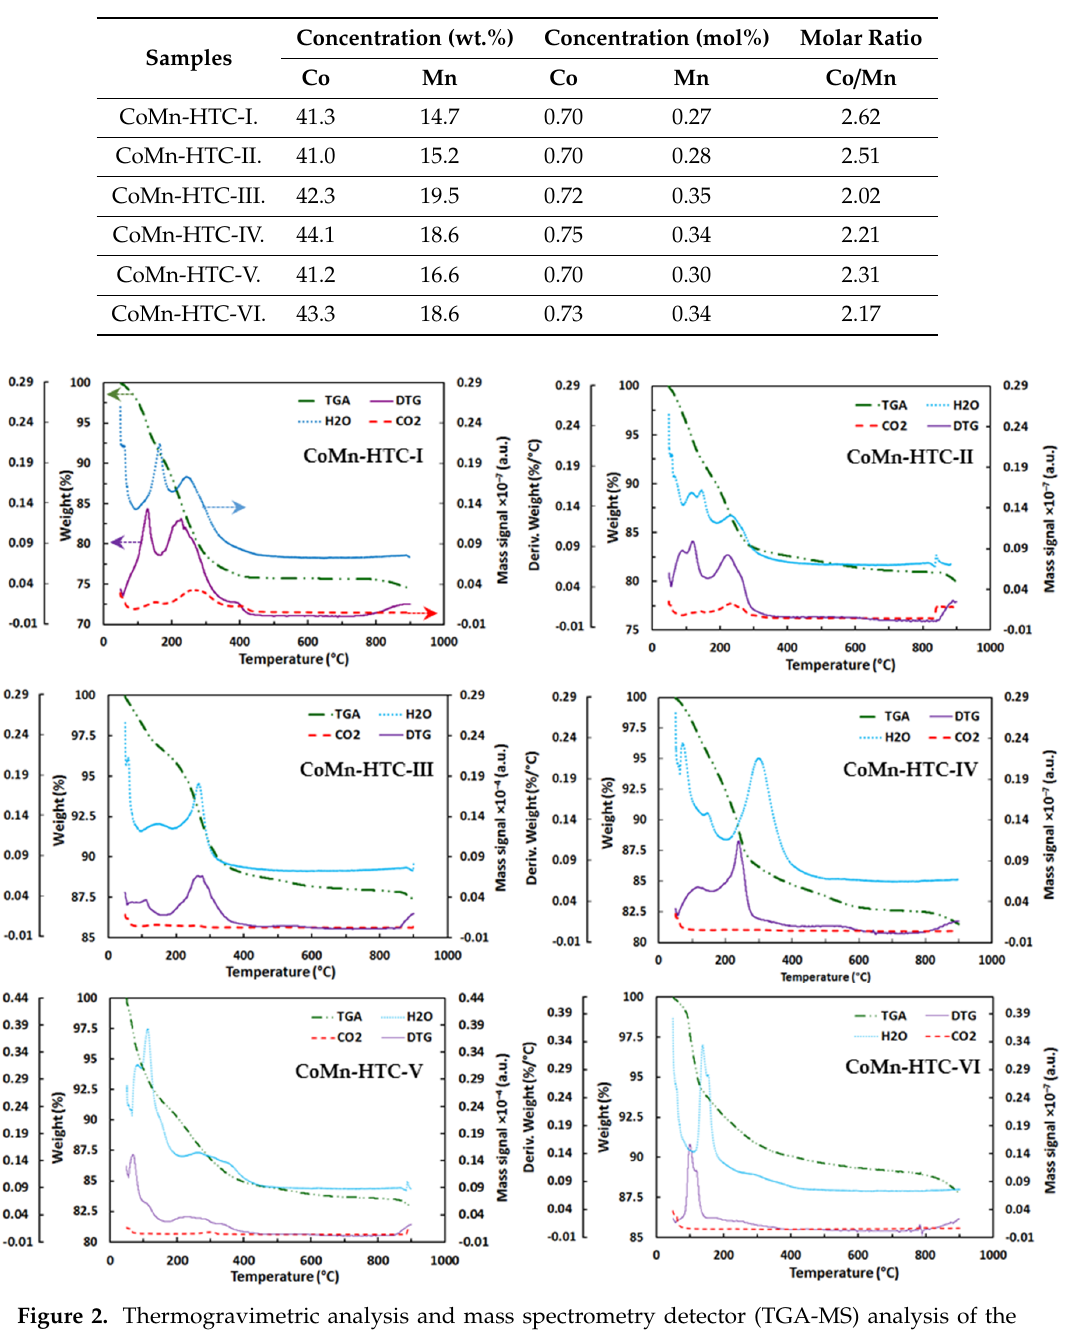
Table 1. Inductively coupled plasma (ICP) analysis of the CoMn-HTC catalysts.